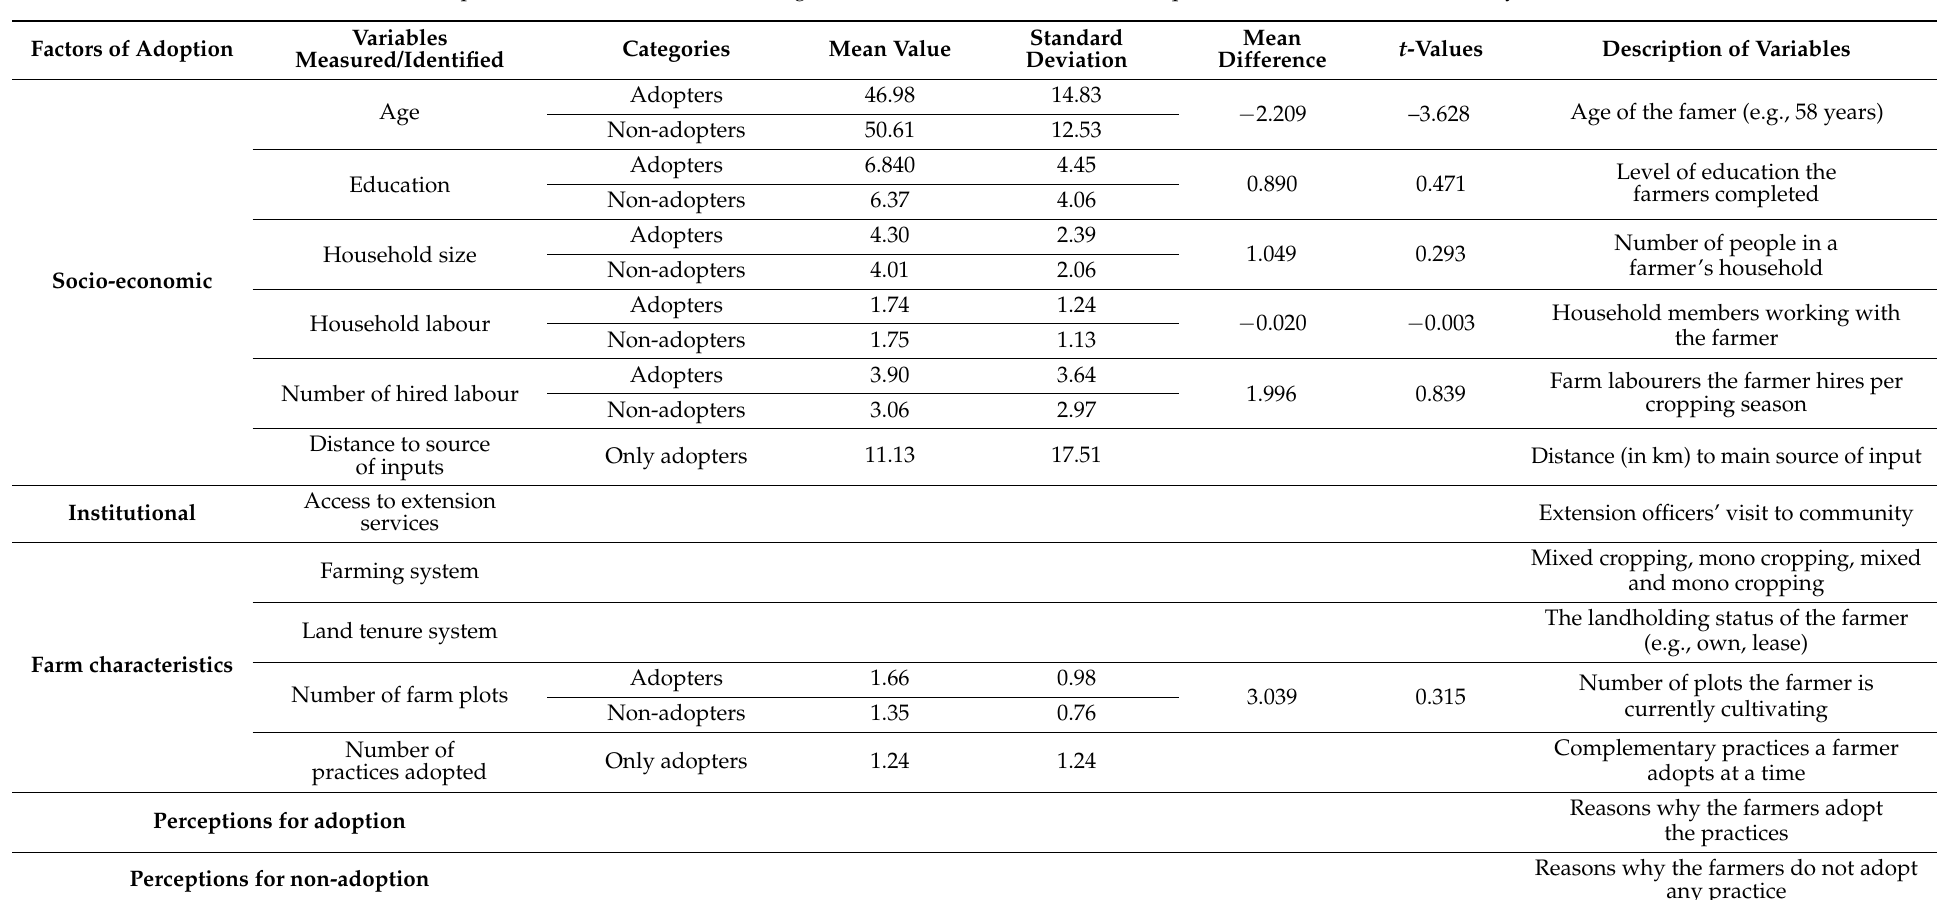
Table 1. Descriptive statistics of variables investigated and the statistical values of the quantitative variables calculated by the